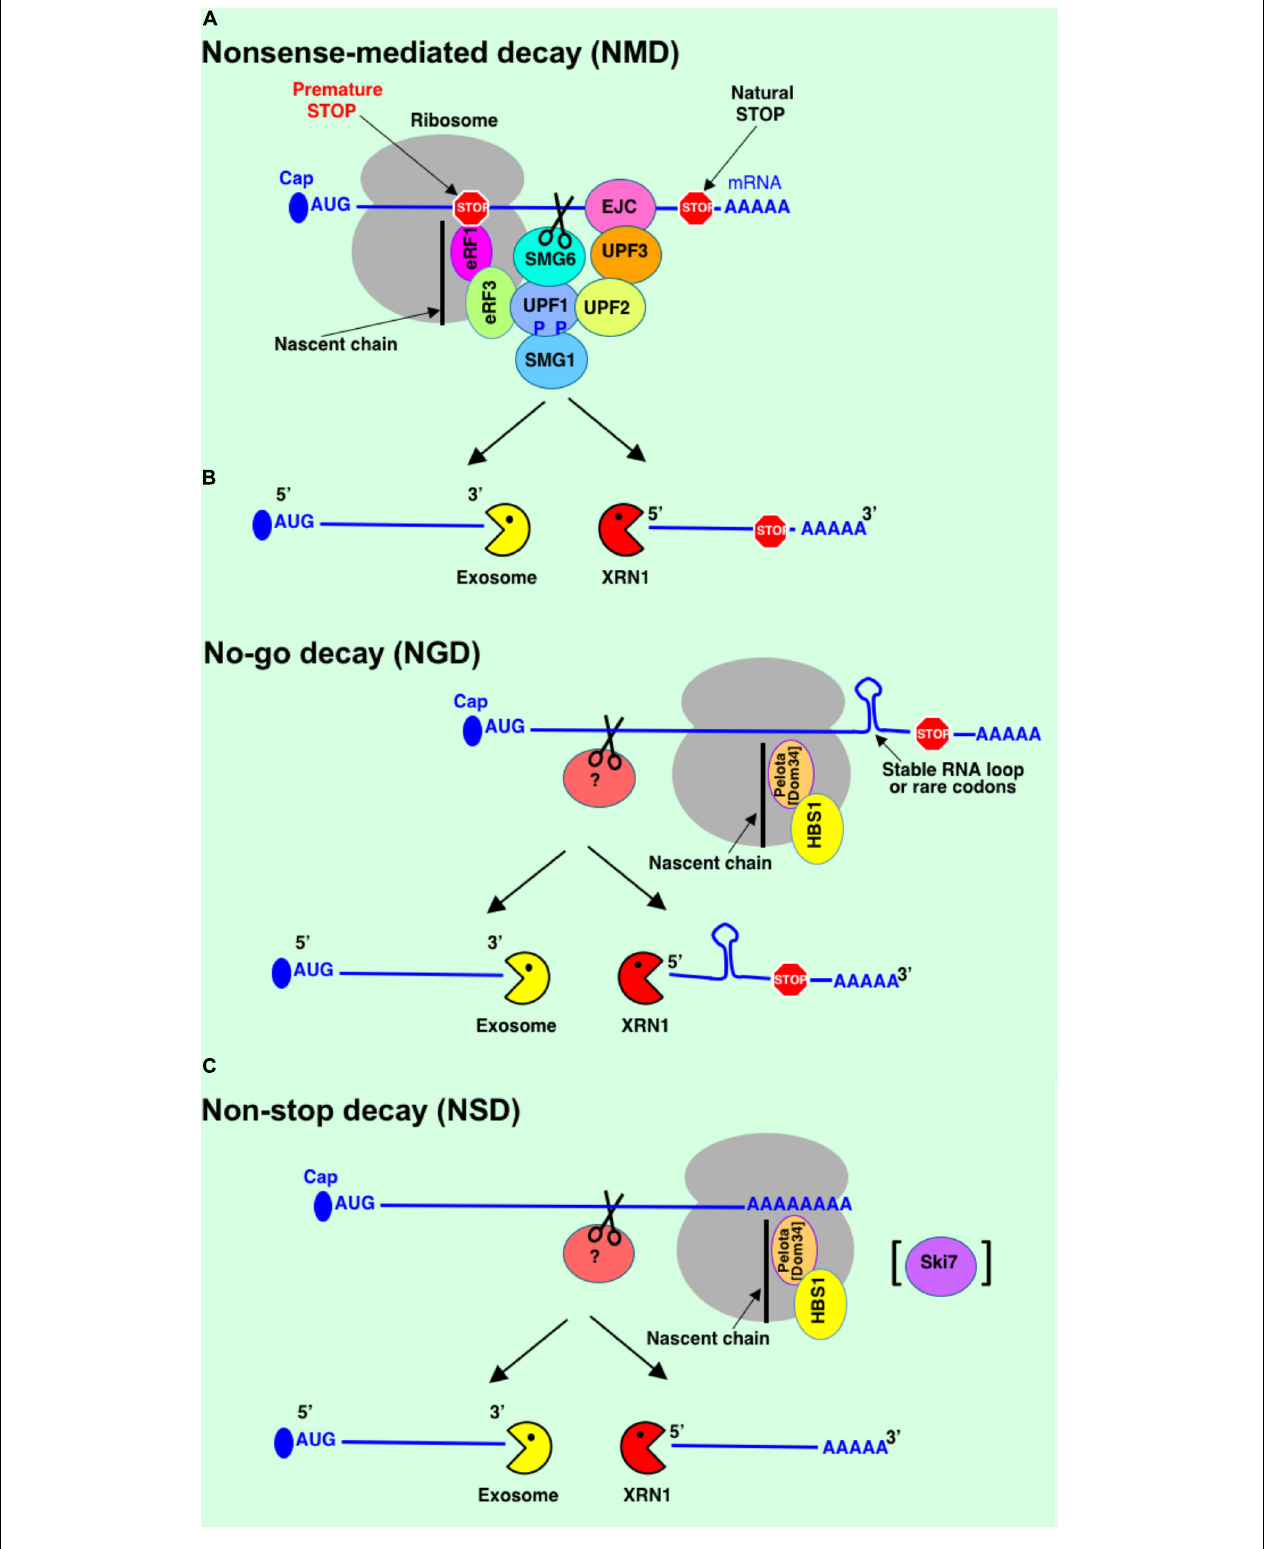
FIGURE 3 | mRNA quality control systems: Nonsense-mediated decay (NMD) (A) , no-go decay (NGD) (B) , non-stop decay (NSD) (C) . See text for details.